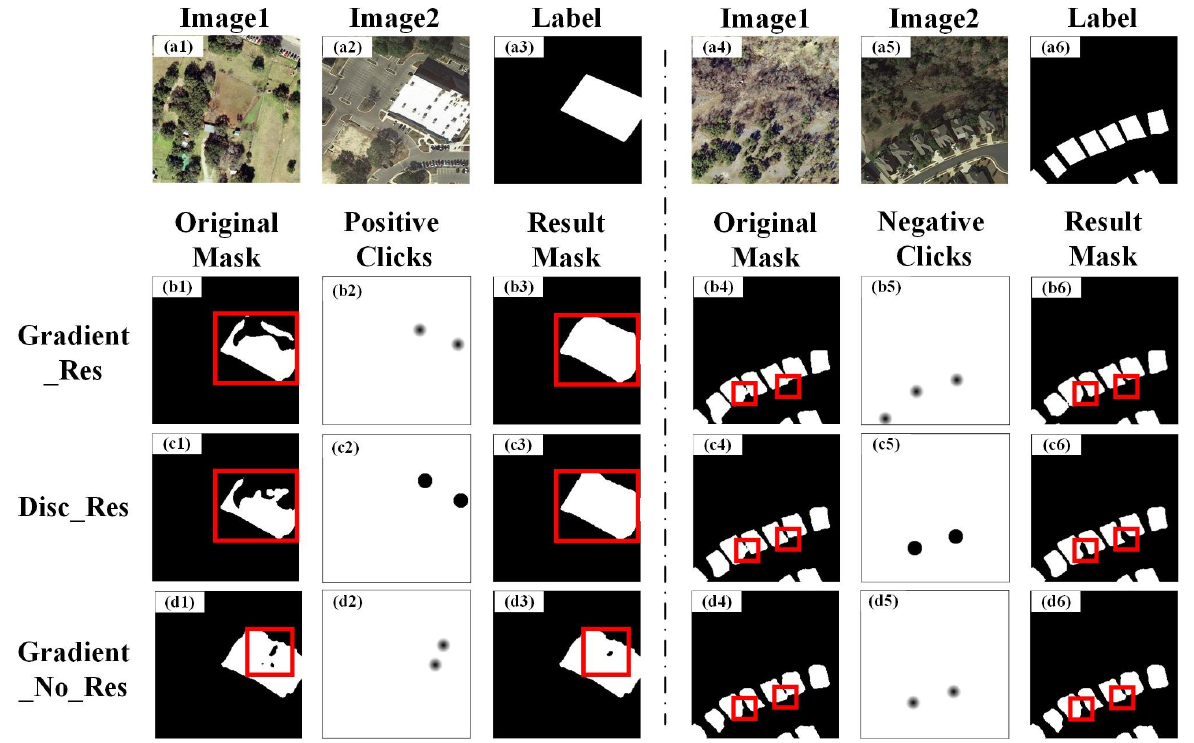
Figure 9. Comparison of correction effects of different models. ( a1 – a6 ) original samples; ( b1 – b6 ) results of Gradient_Res; ( c1 – c6 ) results of Disc_Res; ( d1 – d6 ) results of Gradient_No_Res.